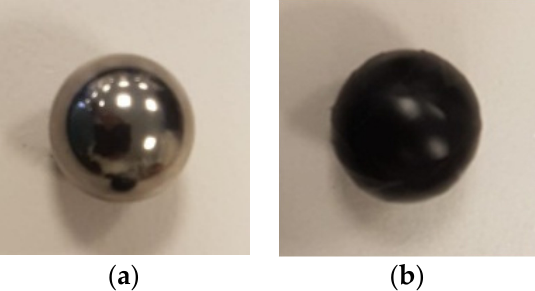
Figure 3. ( a ) The spherical steel ball, which measured 20 mm in diameter and weighed 33 g. ( b ) The steel ball wrapped in black tape.